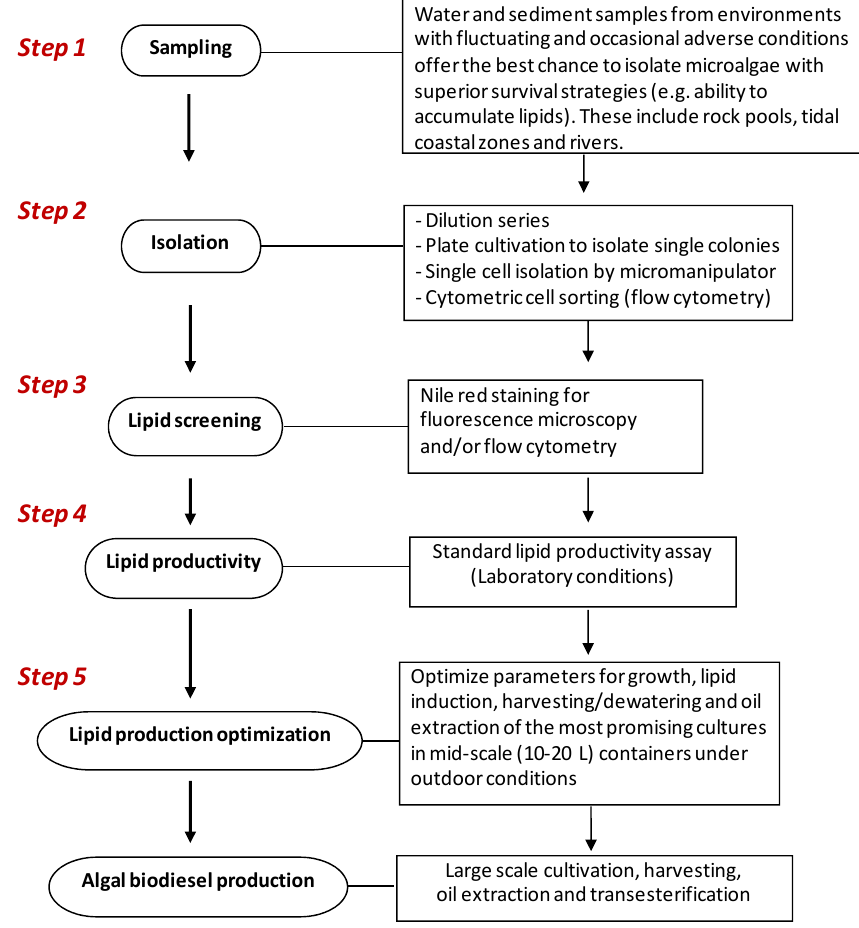
Figure 2. Suggested 5-step protocol for rapid selection of microalgae for